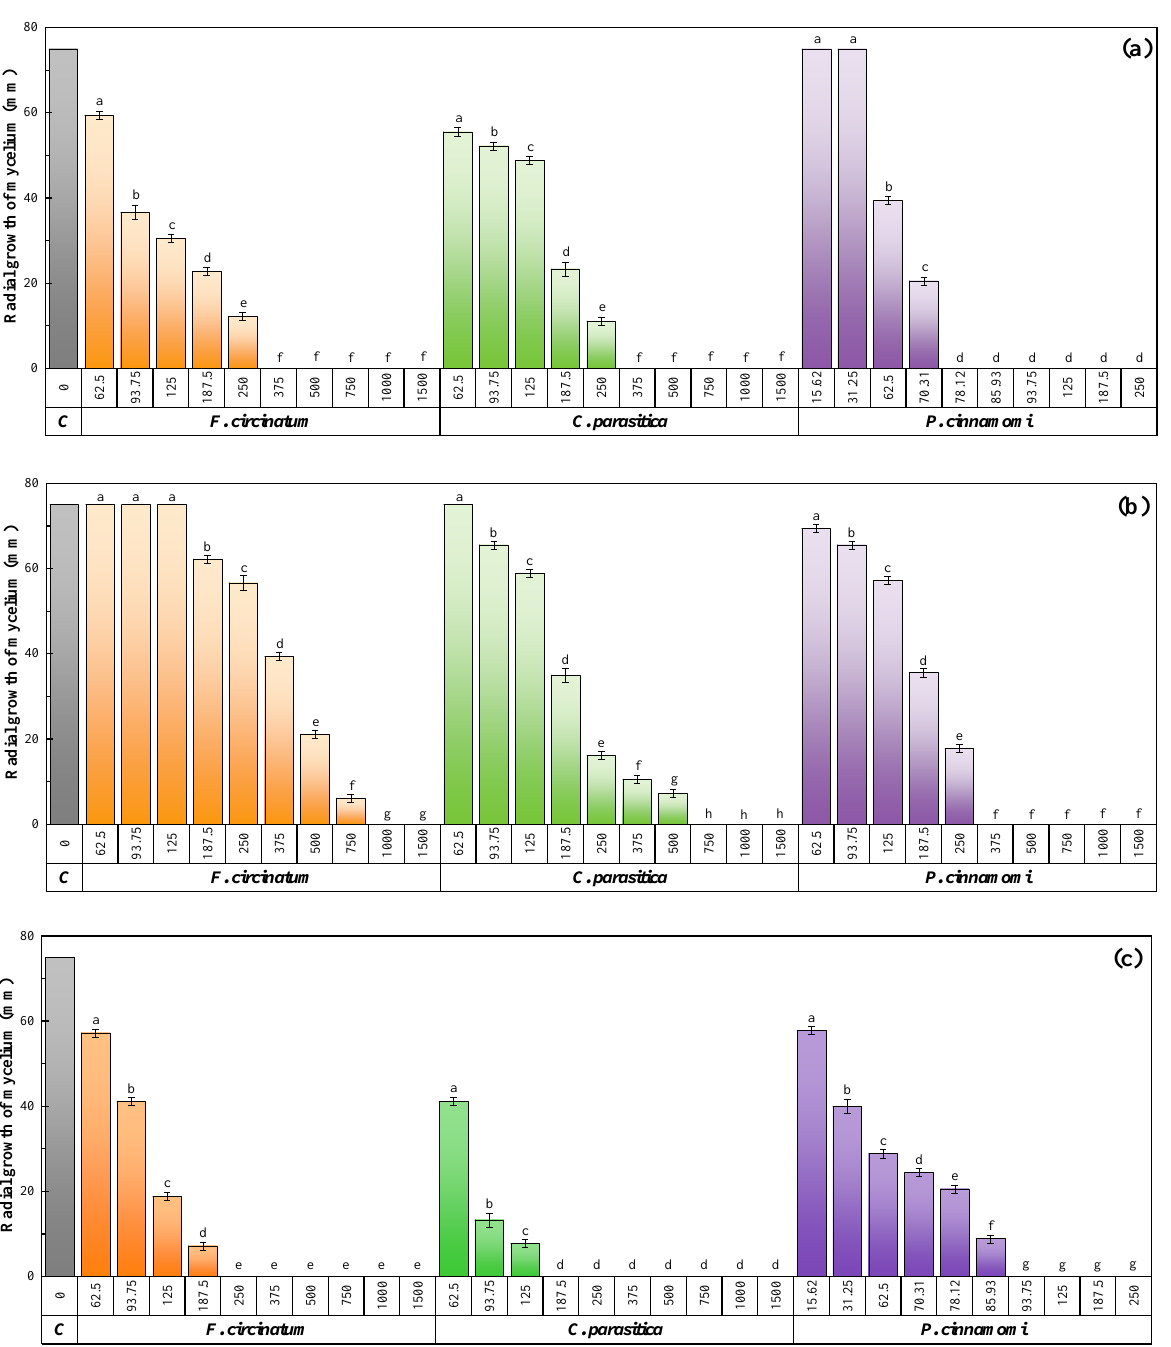
Figure 2. Mycelial growth inhibition attained with ( a ) Q. ilex subsp . ballota bark extract, ( b ) myo - inositol, and ( c ) trans -squalene against F. circinatum , C. parasitica, and P. cinnamomi at concentrations ranging from 62.5 to 1500 μg·mL −1 (or from 15.6 to 250 μg·mL −1 for Q. ilex subsp . ballota bark extract and trans -squalene against P. cinnamomi ). The same letters above concentrations indicate that they are not significantly different at p < 0.05. Error bars represent standard deviations. Table 2. EC 50 and EC 90 effective concentrations (in μg·mL −1 ) of Q. ilex subsp . ballota bark extract and its main constituents against the pathogens under study.